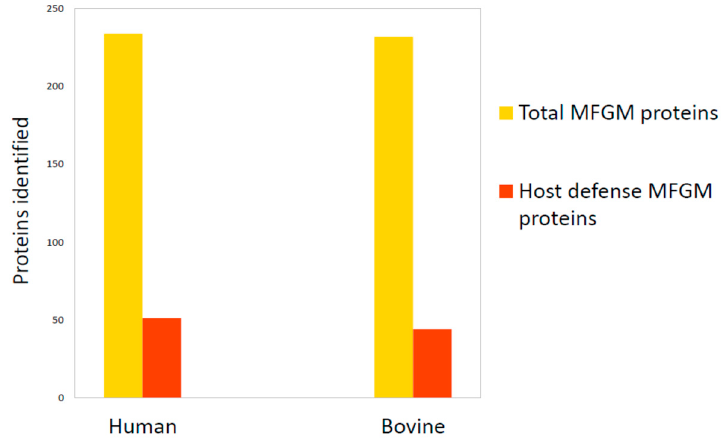
Figure 4. Comparison of total MFGM proteome and host defense MFGM proteins between humans and bovines. Data are from Hettinga et al., 2011 [66].